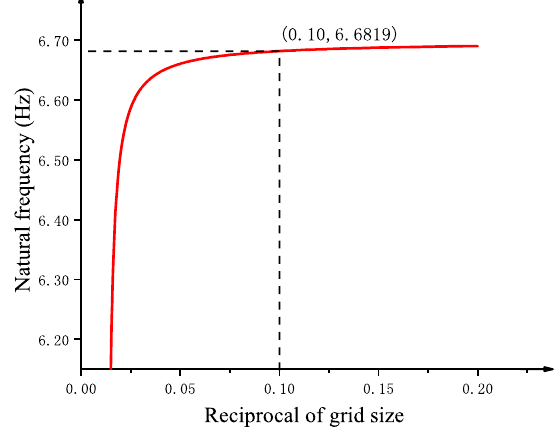
Figure 8 Mesh size convergence